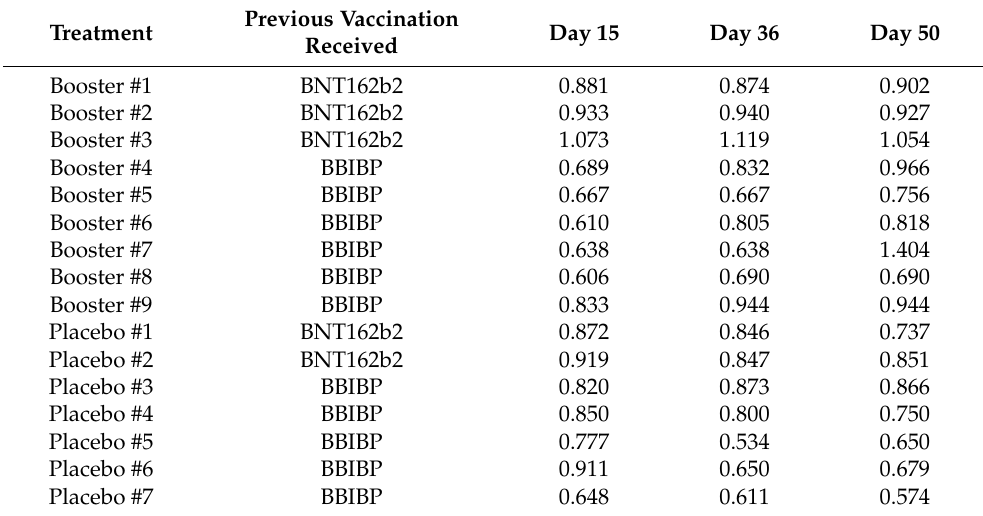
Table 2. Normalized levels of neutralizing antibody for all participants over time.